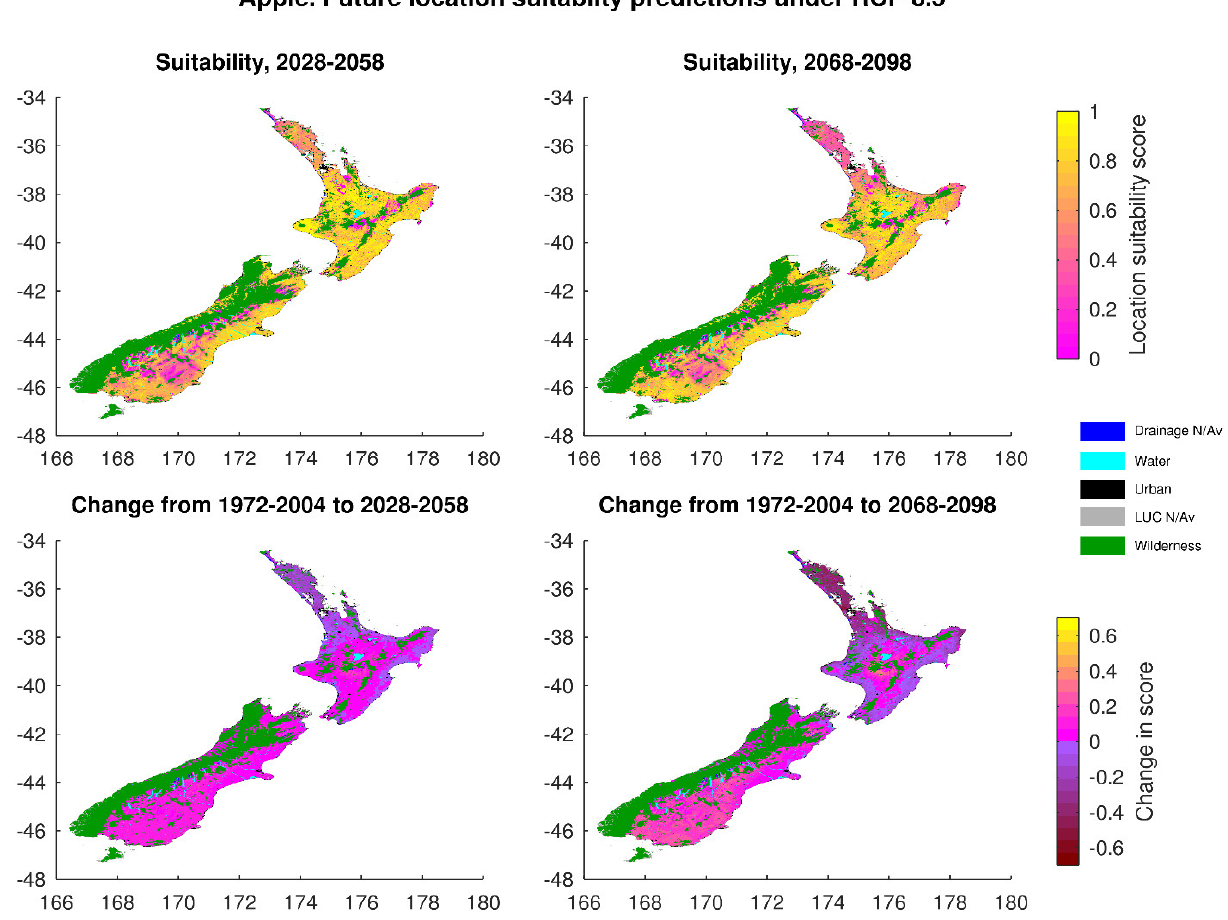
Figure 5. Apple: projected location suitability ( top panels) and projected changes in location suitability from the historic period ( bottom panels) for the mid-century ( left panels) and late-century ( right panels) in New Zealand under Representative Concentration Pathway (RCP) 8.5.